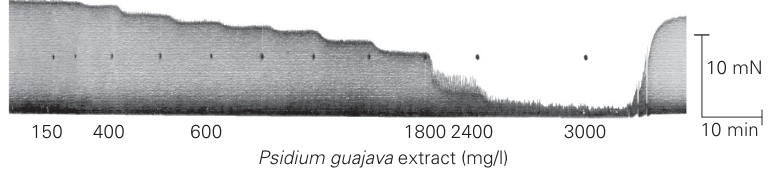
Figure 1. Negative inotropic effect promoted by a crude extract of Psidium guajava L. on an artificially paced guinea pig left atrium. The pace conditions were 2 Hz, 100 V, 0.5 ms, 27 ± 0.1 (cid:1) C. Similar results were observed in 10 other hearts. Forces were statistically different from that measured for the control before addition of the extract (P<0.05, Student